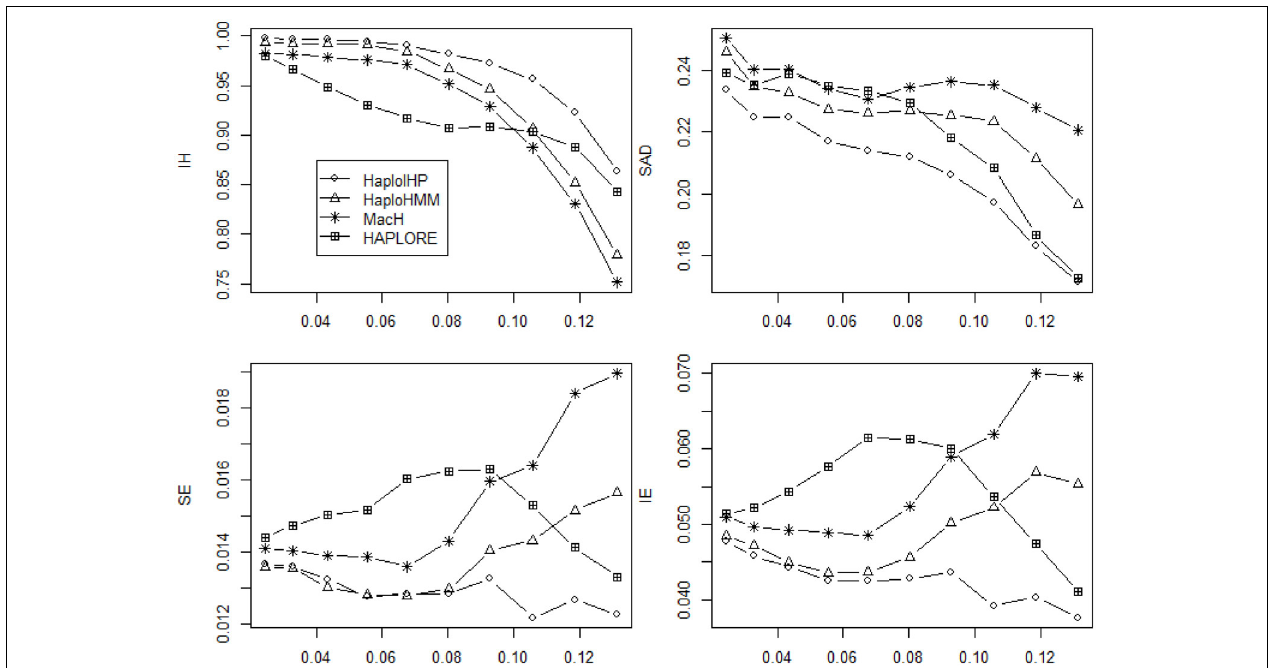
FIGURE 5 | Average values of six measures ( IH , SAD , SE , and IE ) over 500 replicates with the sample size of 100 and the assumption of HWE under different haplotype frequency distributions. The x-axis represents